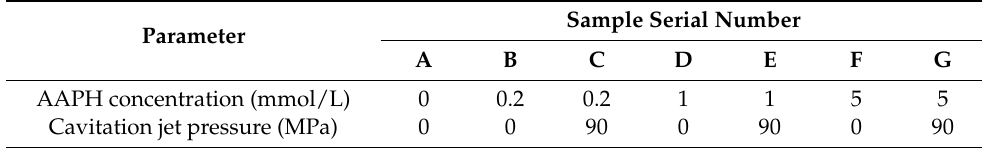
Table 1. Different oxidation and cavitation jet treatment sample